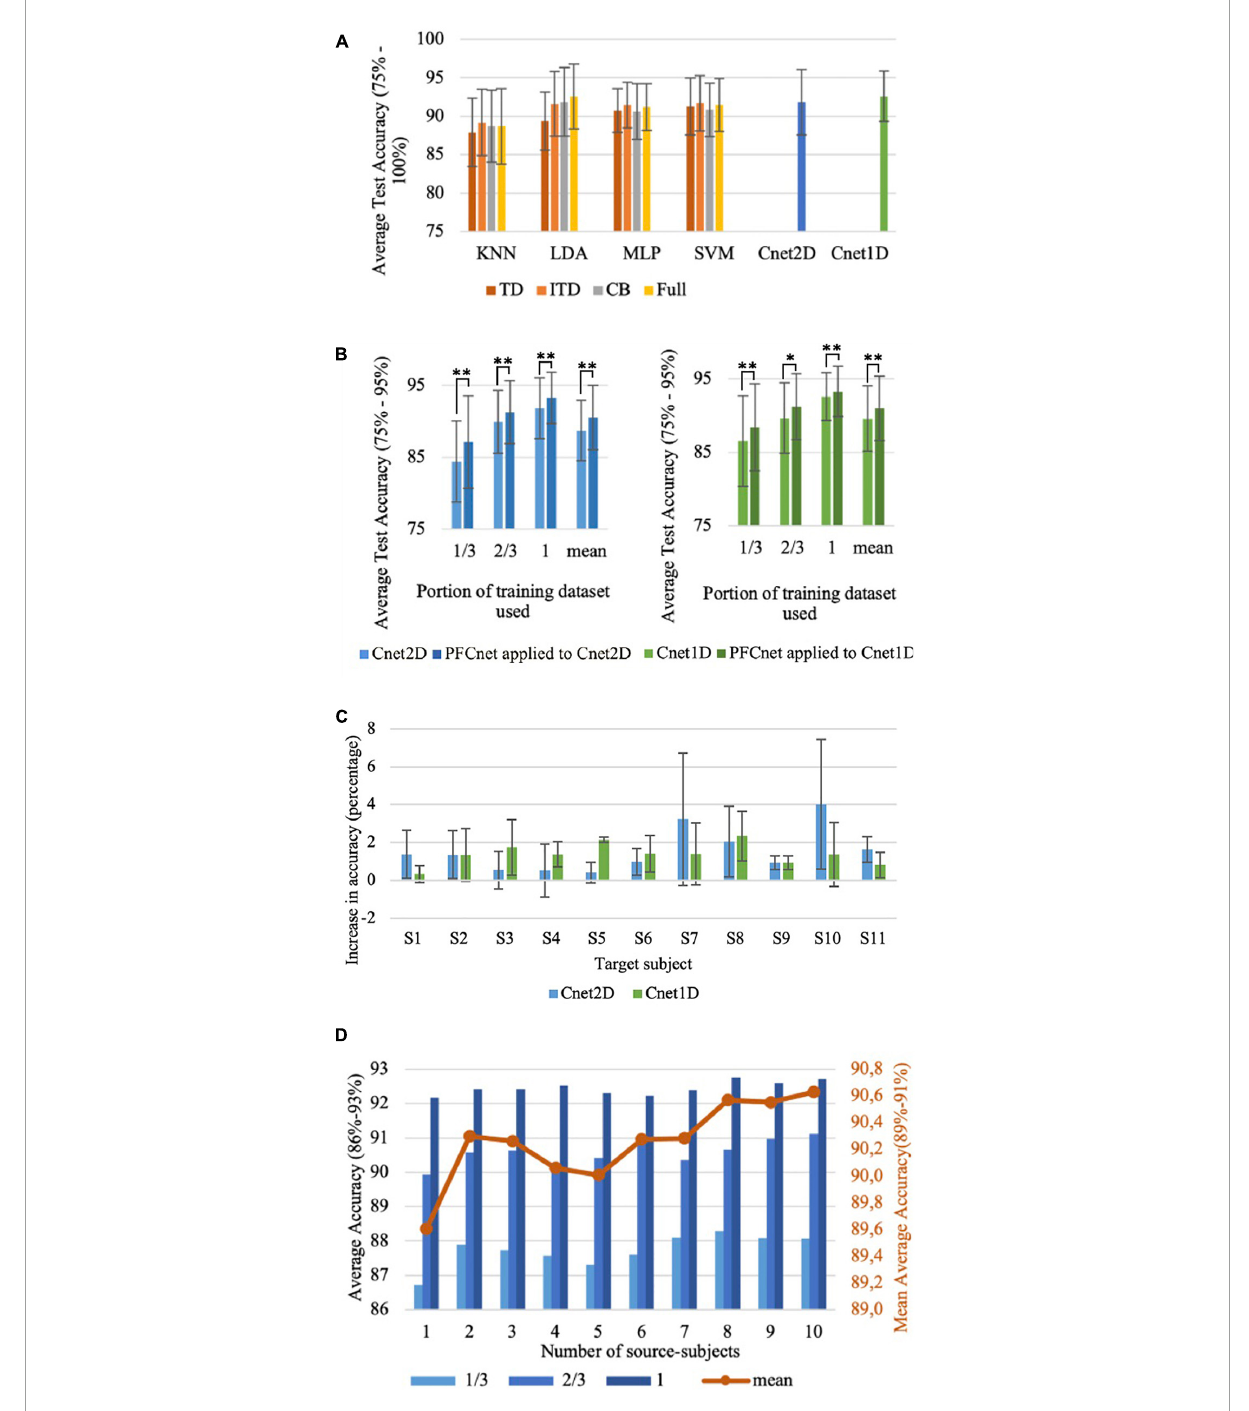
FIGURE6 Nearlab dataset results with 8 classes (chance accuracy level = 12.5%). (A) Comparison between reference classical classifiers with 4 feature sets and the proposed deep networks for Nearlab database. (B) Effect of subject-transfer for Nearlab database when training with different training database sizes. Left is when PFCnet was applied to Cnet2D, and right is the result for applying PFCnet to Cnet1D ( ∗ Corresponds to p < 0.05 and ∗∗ Means p < 0.01). (C) Accuracy improvement when subject-transfer learning is applied to Cnet1D and Cnet2D for each individual of the Nearlab dataset. (D) Average accuracy of PFCnet using increasing number of source subjects (selected randomly), across all Nearlab subjects when using 1/3, 2/3, and 3/3 of the target subject’s training data. The red line represents the mean over average accuracies when 1/3, 2/3, and 3/3 are used. In order to better visualize the differences in accuracies, ranges were adjusted to present a zoomed in version of average accuracy in panels (A,B,D)